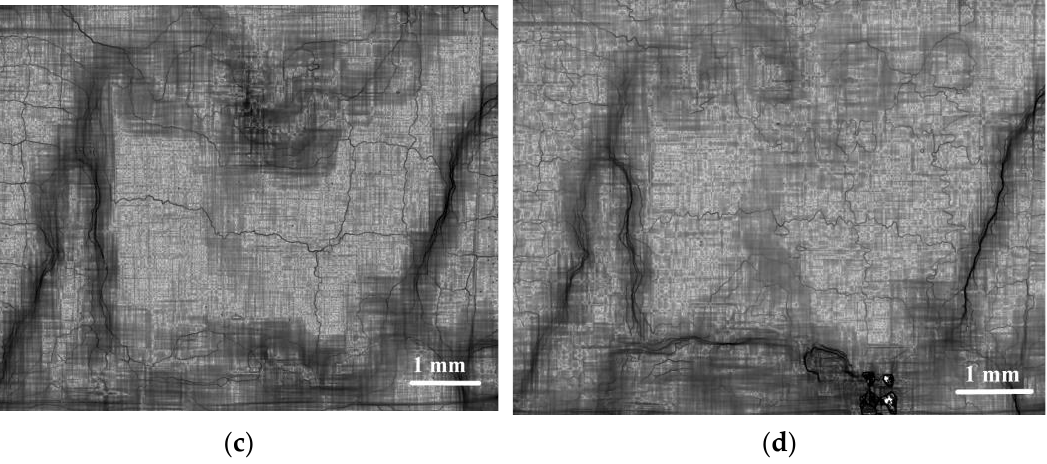
Figure 12. Optical macrograph ( a ) and deformation maps ( b – d ) of Sample #4 at the deformation Stage III at strain are as follows: ε = 0.068 ( a ) , ε = 0.060, ∆ ε = 0.0063 ( b ), ε = 0.064, ∆ ε = 0.0063 ( c ), and ε = 0.071, ∆ ε = 0.0063 ( d ).